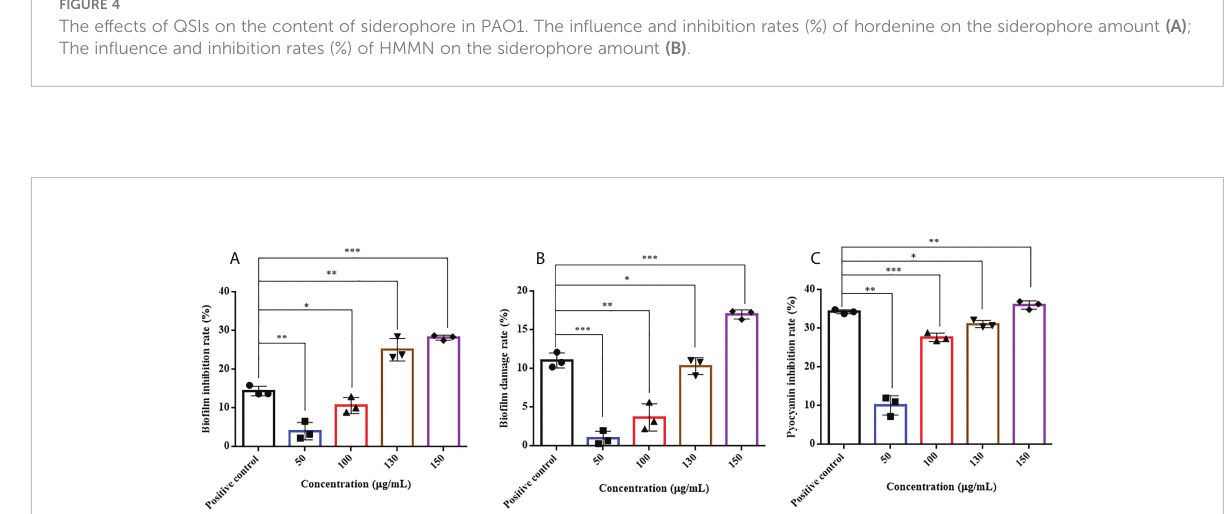
FIGURE 5 The effects of HMMN on bio fi lm and virulence factor pyocyanin in P. aeruginosa PAO1. the inhibition rates (%) of bio fi lm (A) ; The damage rates (%) of bio fi lm (B) ; The inhibition rates (%) of pyocyanin (C) . * p < 0.05, ** p < 0.01, and *** p <